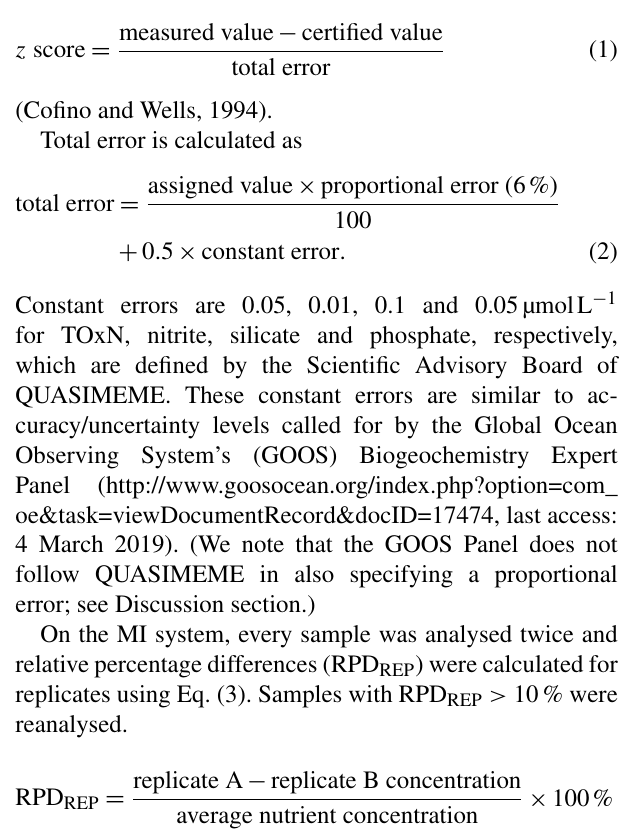
Table 3. Certified values in µmol/kg for the two batches of KANSO CRMs used on the survey. These were converted to µmolL − 1 for comparison with Skalar data using a laboratory temperature of 20 ◦ C and CRM